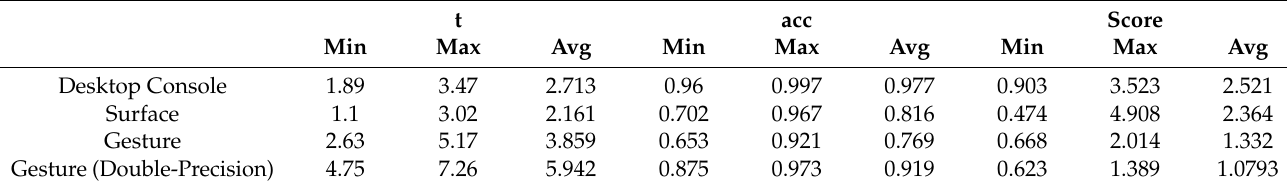
Table 3. Statistics table of movement task